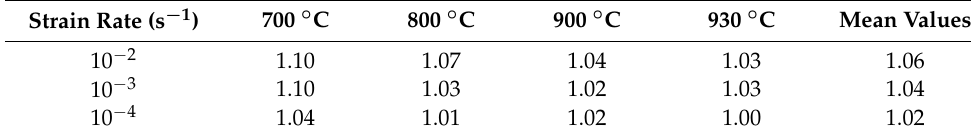
from Equation (10). 𝑏𝑏